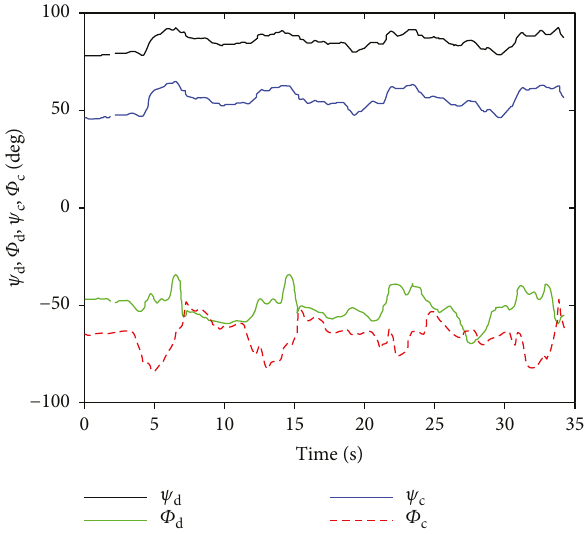
Figure 12: The joint angle φ